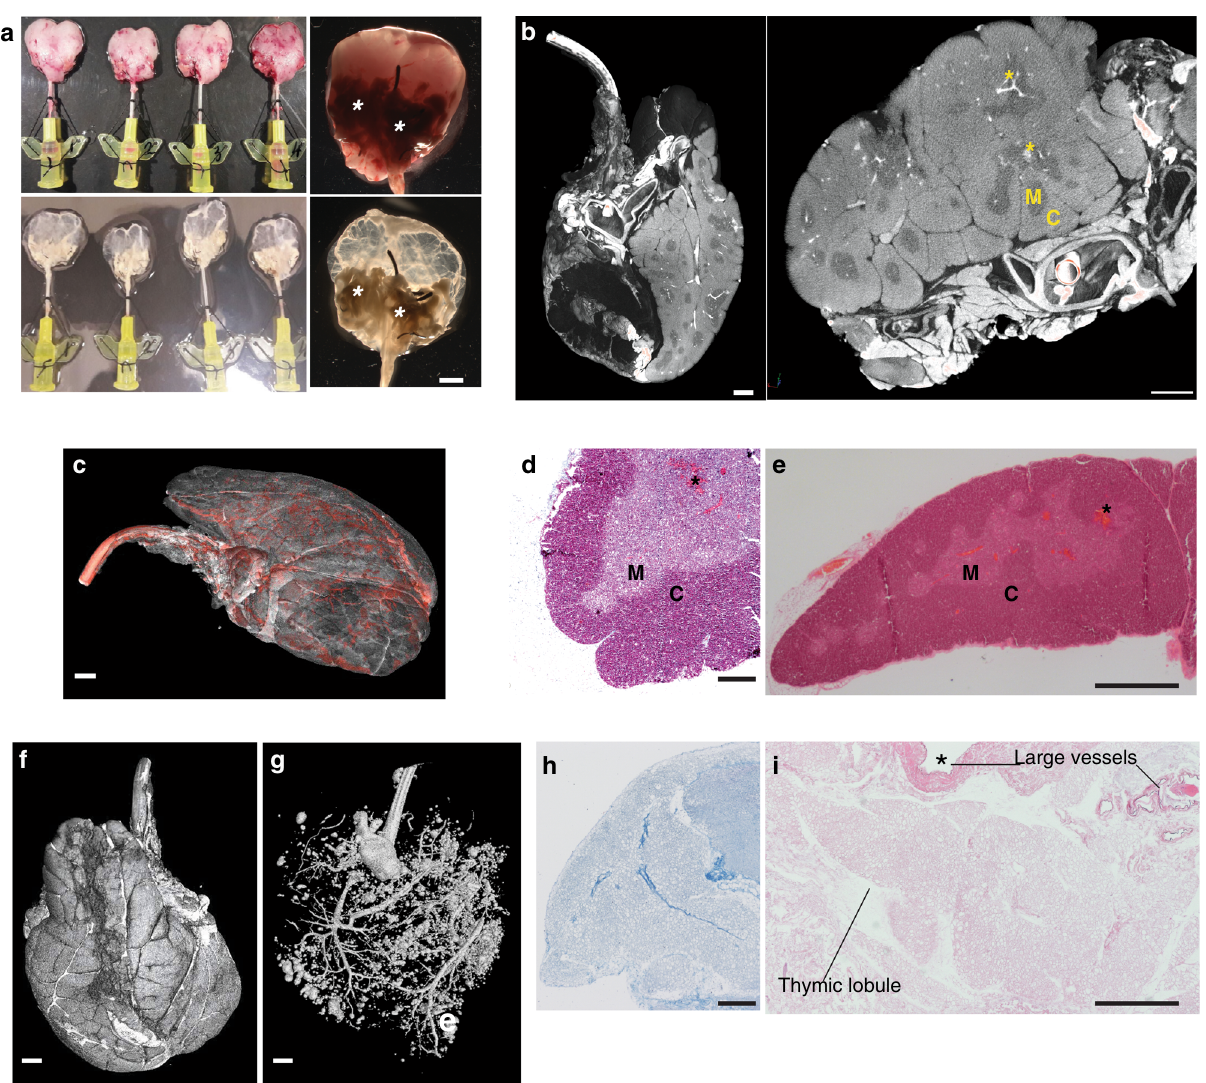
Fig. 4 Whole-organ thymus perfusion and decellularisation. a Gross appearance of cannulated rat thymi before (upper panels) and after (lower panels) decellularisation. A 24G cannula is inserted into the carotid artery and used to perfuse the organ with detergent and enzymatic solutions. Asterisks indicate extra-thymic tissues that allowed connection between thymic tissue and cannula through the large blood vessels ( n = 120). Scale bar, 2 mm. b Micro-CT images of cannulated rat thymus showing extra-thymic tissues, large blood vessels and the 24G cannula entering the artery. Iodine contrast shows clear demarcation between cortex (C, bright) and medullary (M) areas; blood vessels (asterisks) are represented by very bright areas between and inside the parenchyma ( n = 3). Scale bar, 1.5 mm. c Micro-CT 3D image of whole rat thymus cannulated where iodine contrast shows vasculature tree (segmented in red, n = 2). Scale bar, 1.2 mm. d Masson ’ s trichrome stain of a fresh rat thymus lobe staining in red keratins, in blue collagen and in pink cytoplasm. C cortex, M medulla ( n = 3 thymi). Scale bar, 250 μ m. e Haematoxylin & Eosin (H&E) stain of a fresh rat thymus. C cortex, M medulla ( n = 3 thymi). Scale bar, 500 μ m. f Micro-CT image of cannulated rat thymus showing the whole 2 lobes in 3D. Scale bar, 1.2 mm. g Micro-CT image of a cannulated rat thymus injected with Micro fi l ® and thresholded to demonstrate perfusion of both thymic lobes. Scale bar, 1.2 mm. h Masson ’ s trichrome stain of a paraf fi n section of a decellularised rat thymus scaffold demonstrating collagen fi bres (blue) and absence of keratins, muscle fi bres and cell cytoplasm ( n = 3 scaffolds). Scale bar, 250 μ m. i H&E of a decellularised thymus scaffold showing intact thymic lobule ECM and preservation of both large and small vasculature wall ( n = 4 scaffolds). Scale bar, 500 μ